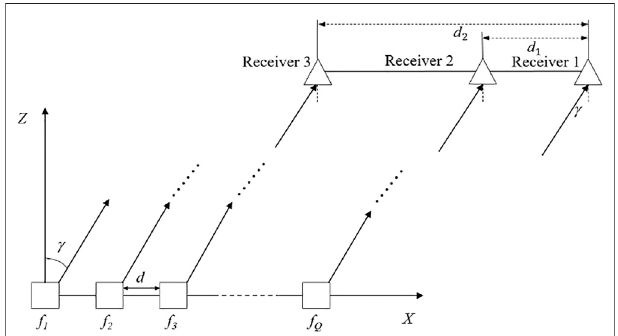
FIGURE3| Thepositionrelationshipbetweentheinterferometerandthe FDA